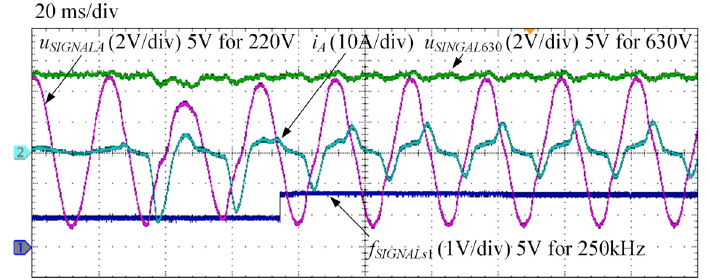
Figure 24. Waveforms when turn on microwave oven and refrigerator in off-line mode.